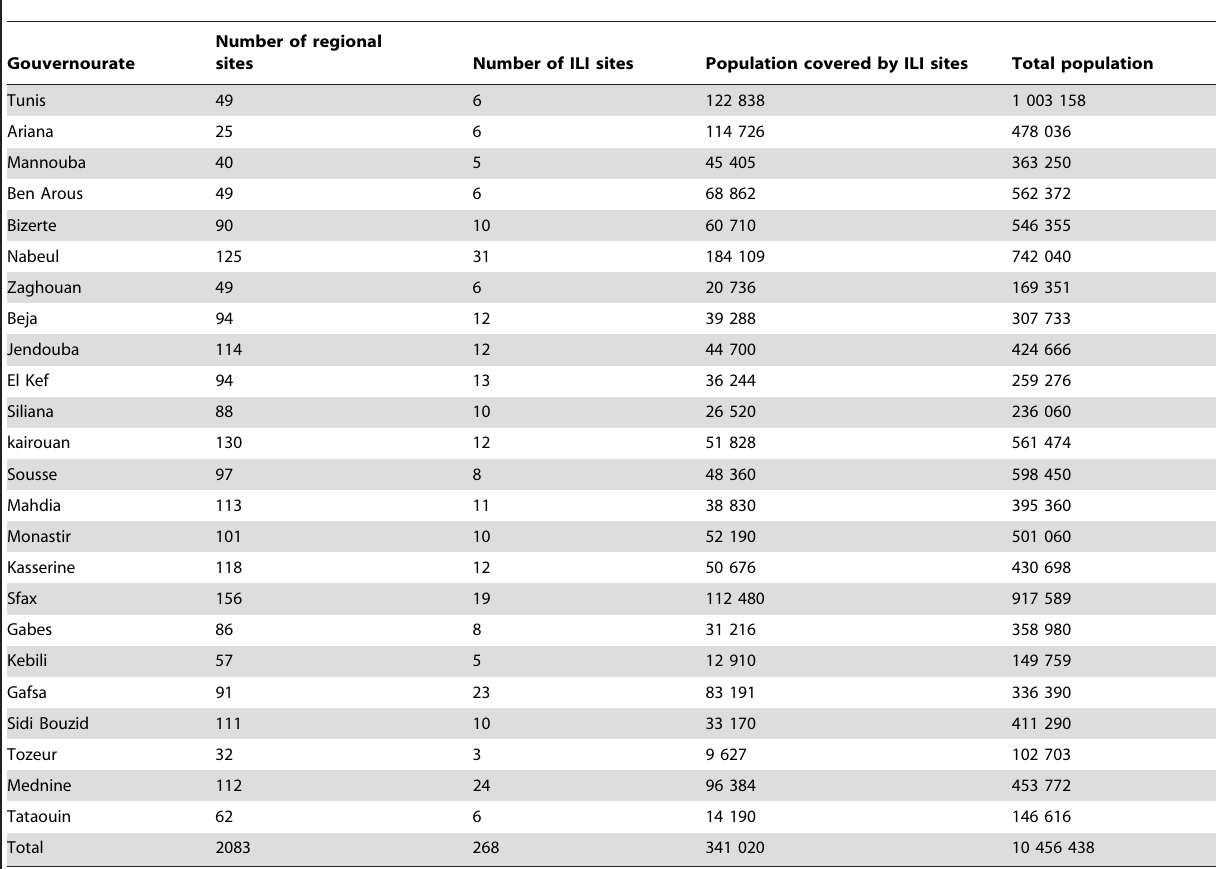
Table 1. Geographic and demographic representation of ILI in Tunisia in 2009–2010